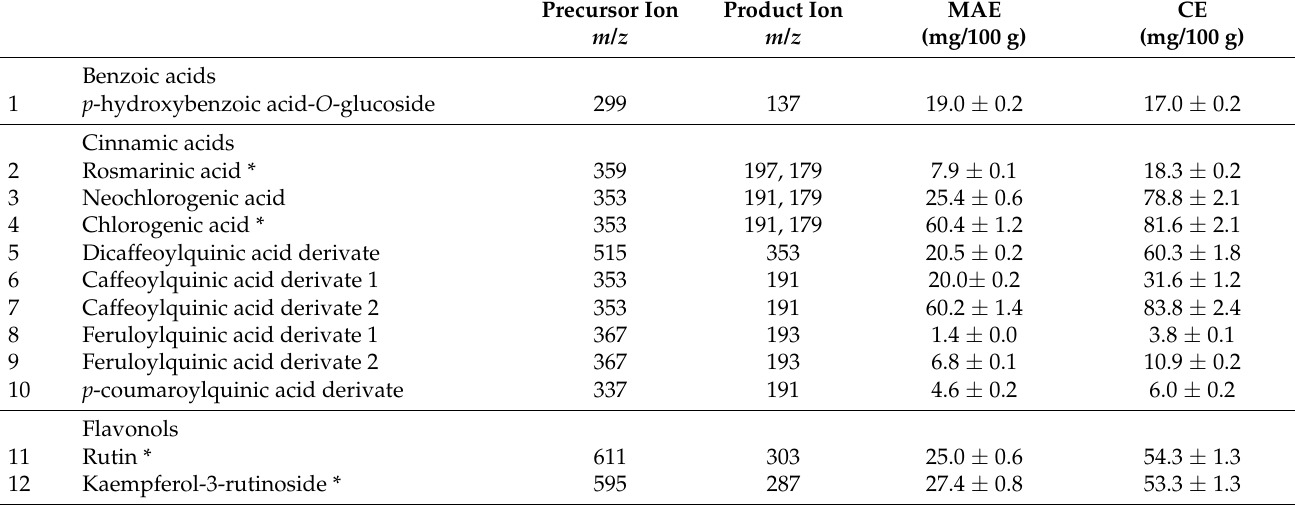
Table 3. Phenolic profile, TPC and ORAC values of fennel seeds extracts obtained under optimized MAE conditions (80 ◦ C, 5 min, 300 W with 30% acetone) and